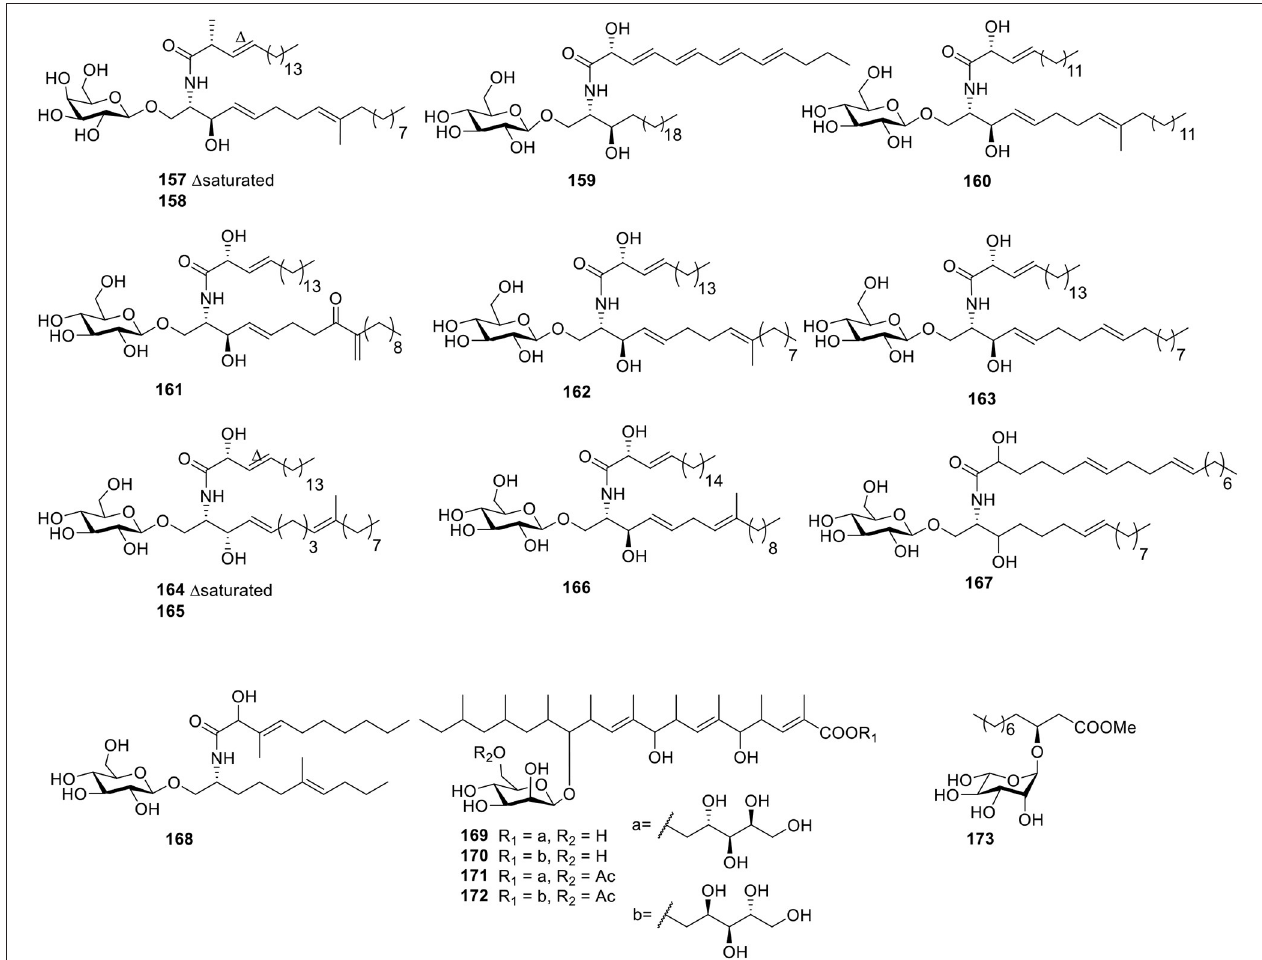
FIGURE 12 | Chemical structures of compounds 157–173 derived from marine-sourced